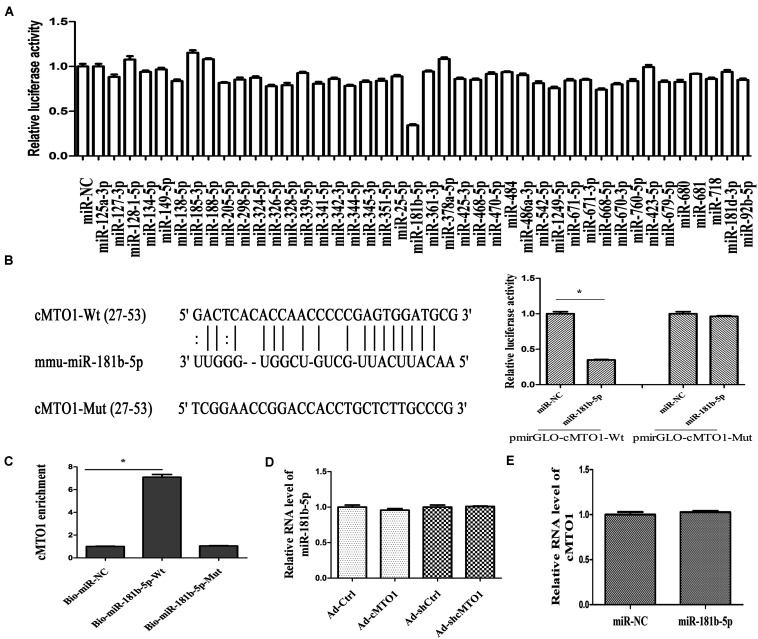
The interaction between cMTO1 and miR-181b-5p. (A) The luciferase activity of pmirGLO-cMTO1-Wt in HEK-293T cells after co-transfection with the indicated 42 miRNAs or miR-NC. (B) A schematic drawing indicated the putative binding sites of miR-181b-5p with respect to cMTO1. Moreover, relative luciferase activities of pmirGLO-cMTO1-Wt or pmirGLO-cMTO1-Mut were analyzed in HEK-293T cells. (C) To validate the direct interaction between cMTO1 and miR-181b-5p, the pull-down assay was performed. Bio-miR-NC is not complementary to cMTO1. (D) Expression of miR-181b-5p in HSCs after Ad-cMTO1 or Ad-shcMTO1 treatment for 48 h. (E) Expression of cMTO1 in HSCs after miR-181b-5p transfection for 48 h. *P < 0.05. Each value is the mean ± SD of three experiments.